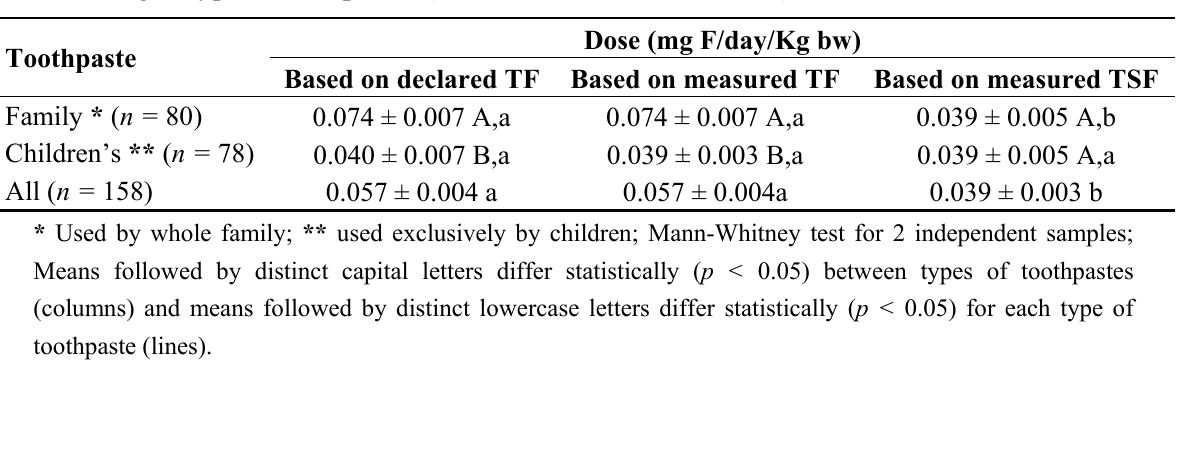
Table 2. Estimated dose of fluoride (mg F/day/Kg of body weight) based on total fluoride (TF) declared on label and TF and total soluble fluoride (TSF) measured in analyses according to type of toothpastes (mean ± standard deviation; n